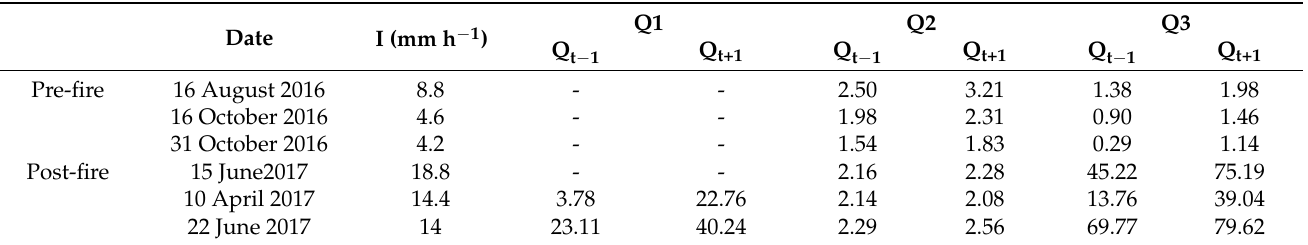
Table 4. Rainfall intensity in 1 h (I) and instantaneous streamflow yield (L s − 1 ) pre- and post-fire (when data were available).